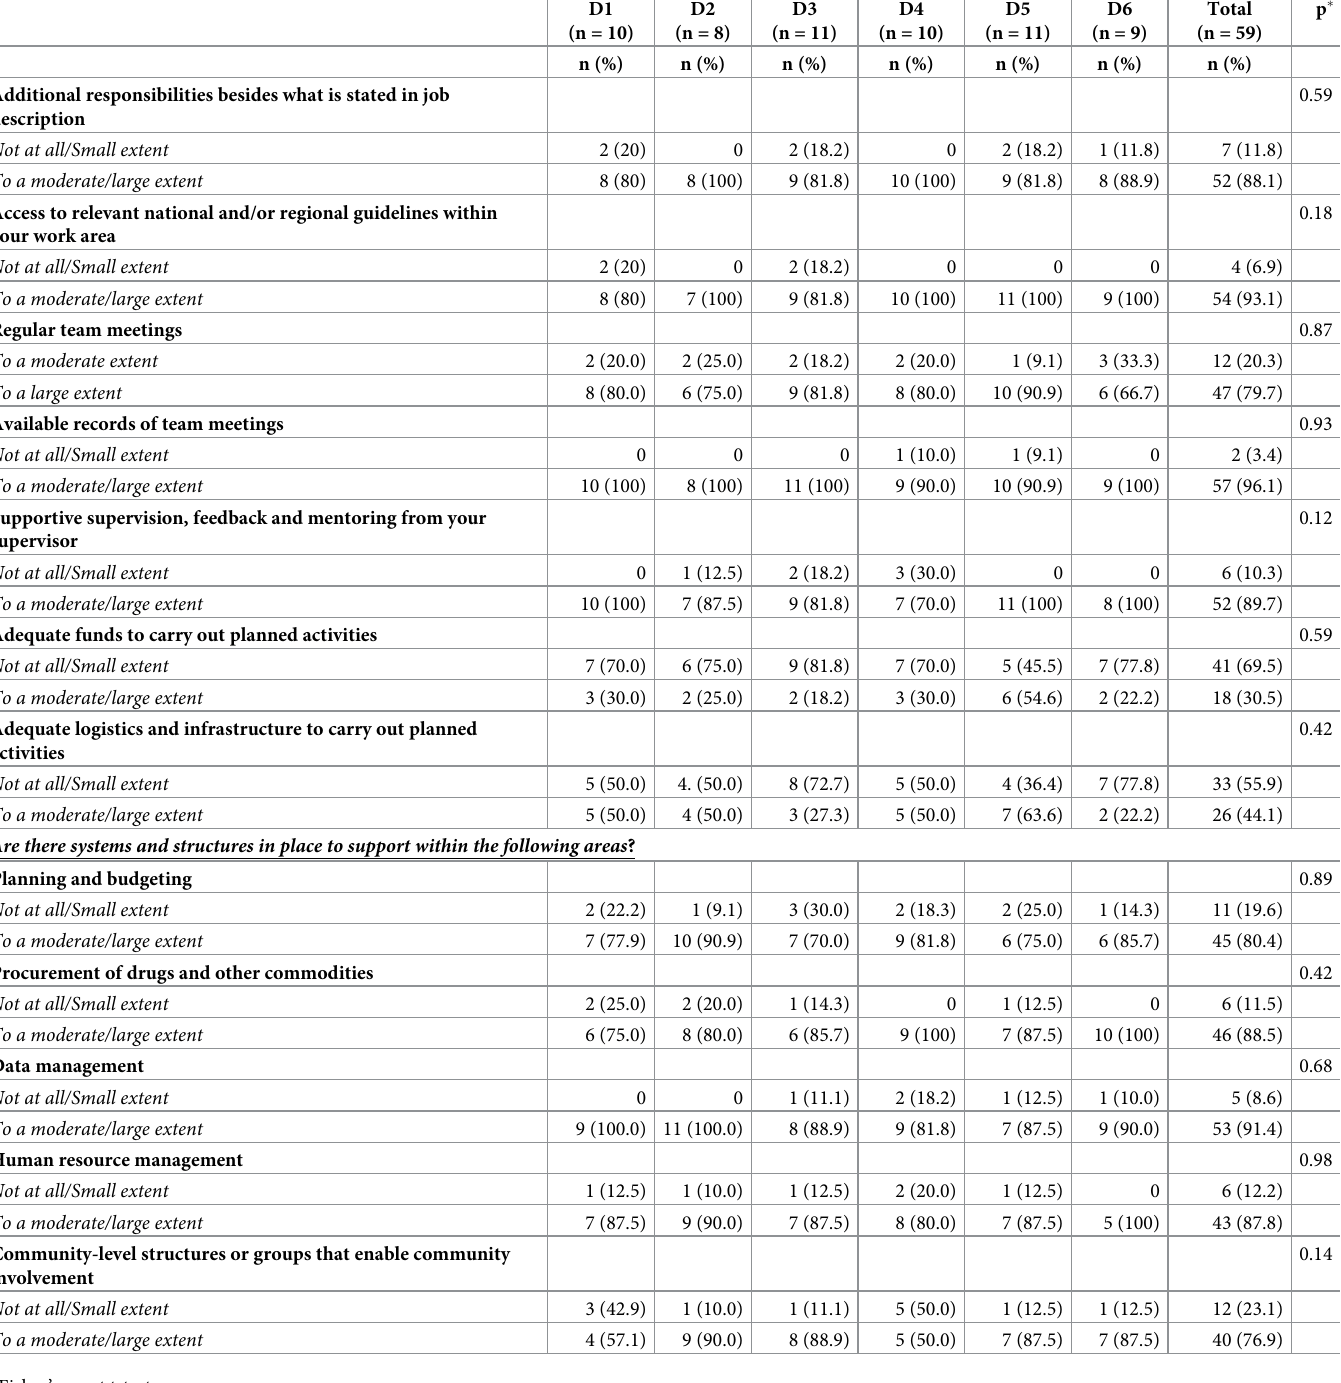
Table 4. Functional support systems across different performing